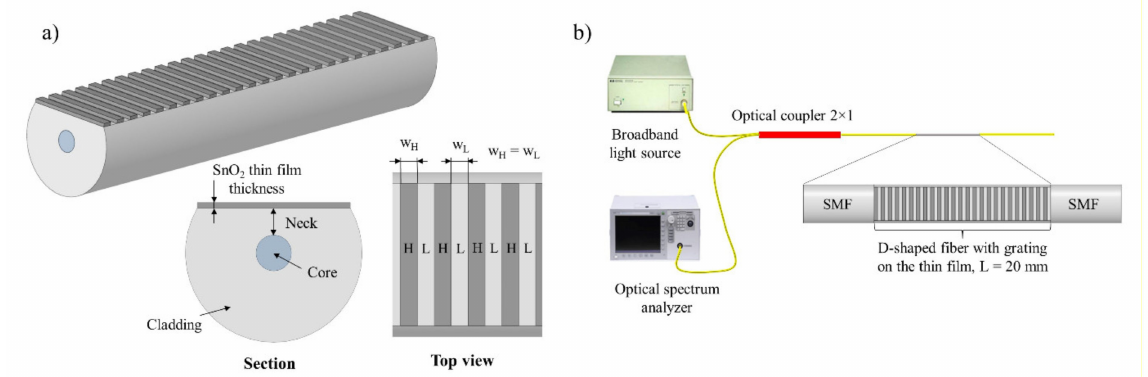
Figure 1. ( a ) A 3D schematic view of the grating on the flat surface of a D-shaped fiber with a close-up of the section and the grating on the lower part of the image. ( b ) The schematic reflection setup that is simulated. All dimensions in this figure are not to